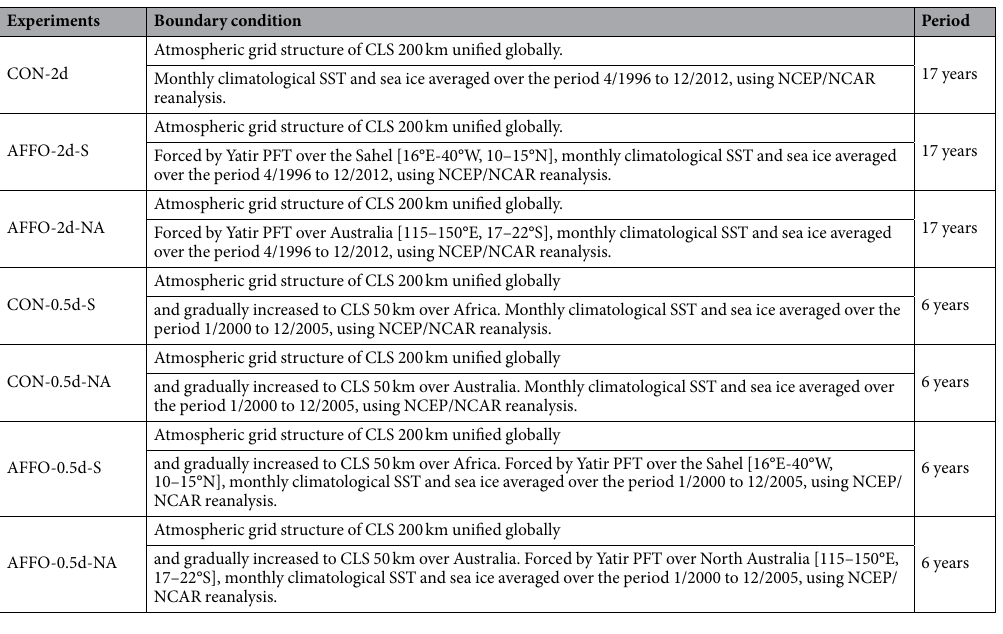
Table 1. Summary of the numerical experiments. Seven numerical experiments were carried out in this study using OLAM and are summarized in Table 1. Control experiments (CON 2d , CON 0.5-S and CON 0.5d- NA ) were integrated from the initial condition taken from at least 1.5 years spin-up experiment for the lower and higher grid resolution. The simulations were forced by the current state of the vegetation classification. The large-scale afforestation experiments (AFFO 2d-S , AFFO 2d- NA, AFFO 0.5d-S , AFFO 0.5d- NA, ) implemented with a land cover classification representing a new PFT of semi-arid planted forest with physical characteristics based on the Yatir semi-arid site (see Table S2). Abbreviations: control simulation (CON), afforestation scenario (AFFO), Sahel (S), North Australia (NA), two and a half degree grid horizontal resolution (2d and 0.5d), characteristic length scale (CLS), sea surface temperature (SST), plant function type